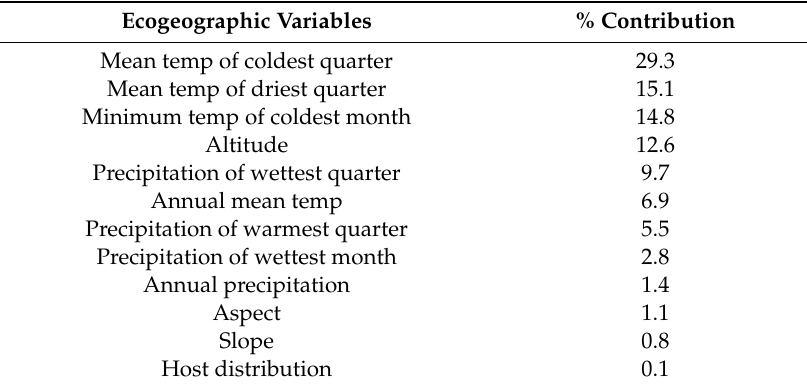
Table 8. Percentage of estimated contribution for EGVs by using